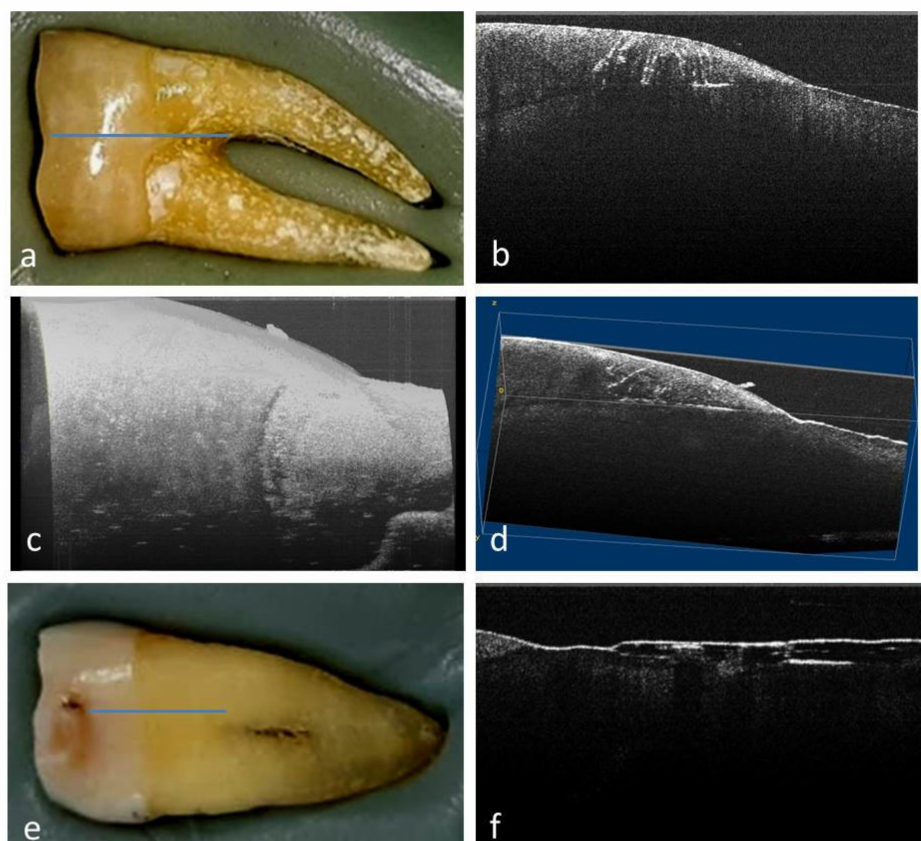
Figure 3. m2 examination: ( a ) macroscopic aspect of buccal surface; ( b ) 2D OCT image of buccal area with crack at enamel–dentin junction and cracks of radial appearance in the enamel; ( c ) 3D image of buccal surface in the cervical area; ( d ) 3D volume viewer image of buccal surface in the cervical area; ( e ) macroscopic aspect of mesial surface; ( f ) 2D OCT image of mesial area with crack in cement.